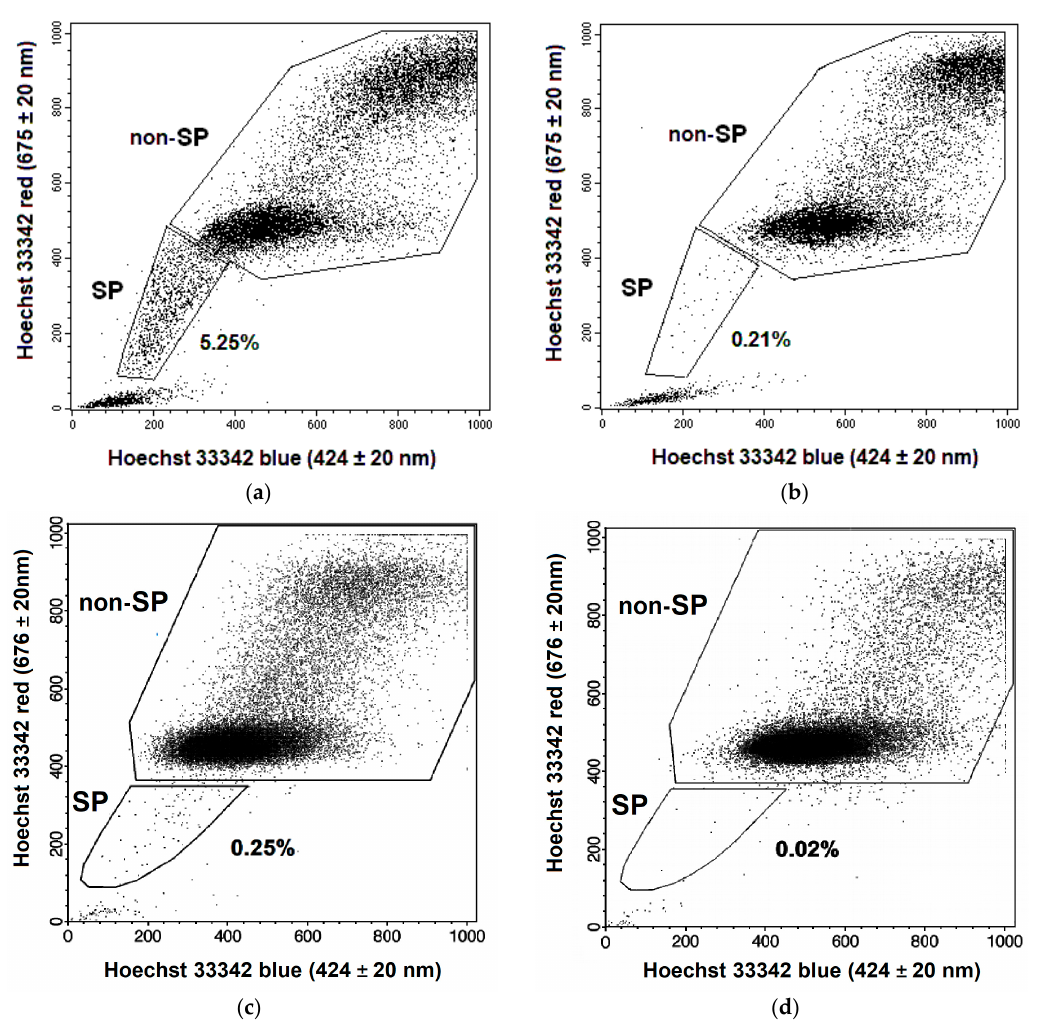
Figure 13. Representative dot plots for Hoechst blue vs. Hoechst red simultaneous emission of HeLa ( a , b ) and SiHa ( c , d ) cells in unexposed samples without ( a , c ) or with the addition of verapamil ( b , d ). The regions of SP and non-SP cells were selected for sorting, and the proportion of SP cells was determined.